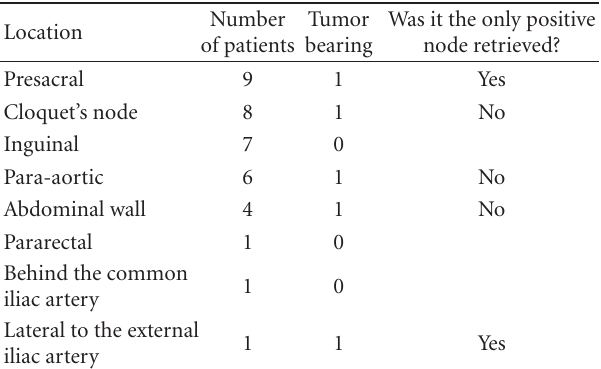
Table 1: Location and pathology results of SNs outside the extended resection area. No = 37 patients (of the